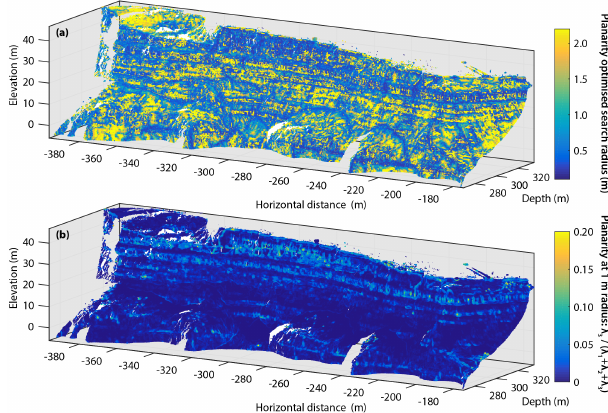
Figure 5. Search radii used for normal estimation across the rock face. (a) The radius for each point on the cliff at which the point clouds are most planar, with a mean value of 1.1m, used to estimate the normal vector prior to change detection. This point cloud was used as a reference model, such that the normal radius of points in subsequent scans was assigned based on the radius of closest point in this scan. (b) Surface planarity at a radius of 1m, where higher values indicate a more 3-D neighbourhood. These occur at inflections in slope profile and in areas of high local relief, such as the sandstone beds near the cliff top. Gaps in point cloud are zones of occlusion illustrated in Fig. 2b.